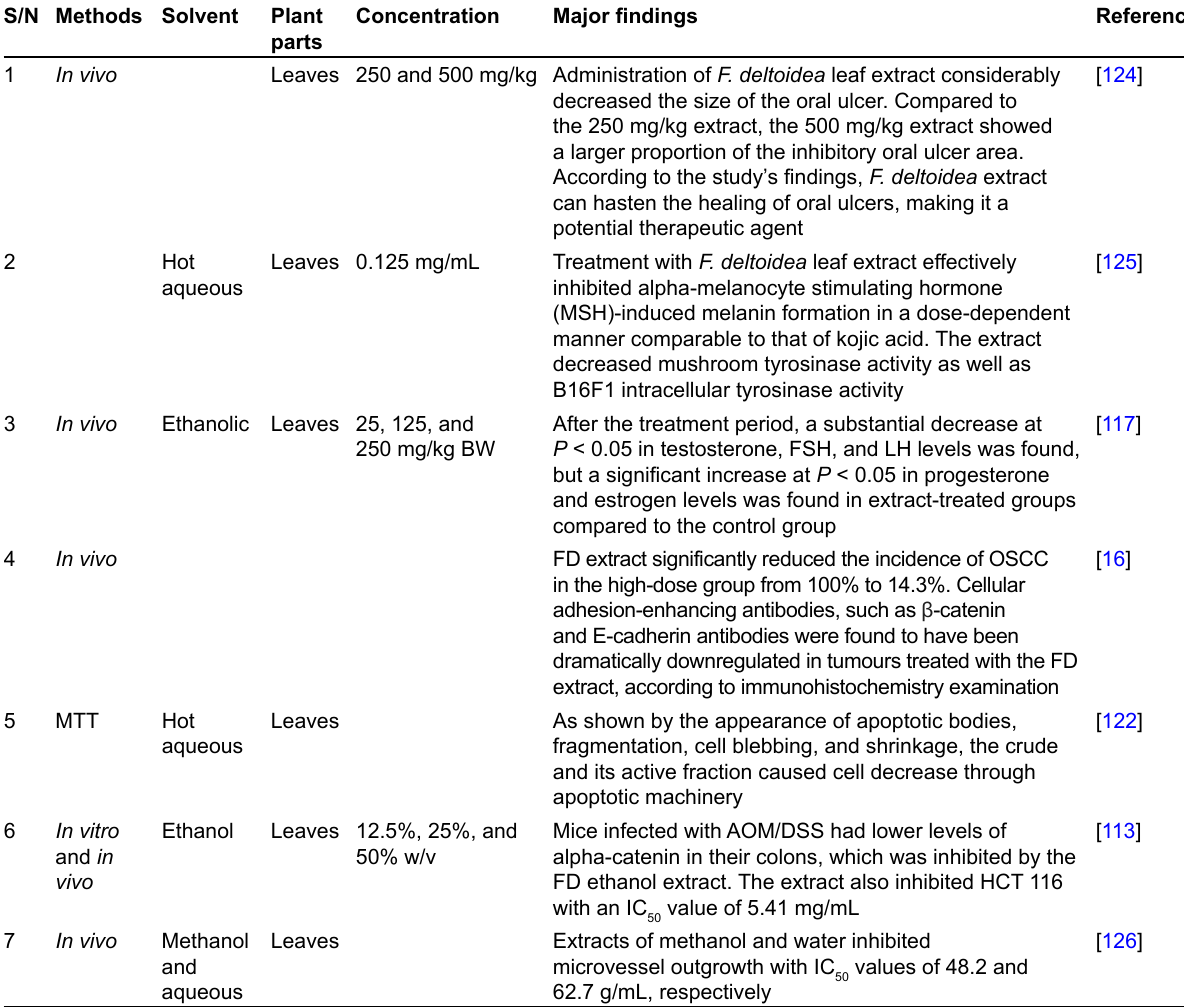
Explor Target Antitumor Ther. 2023;4:57–88 |